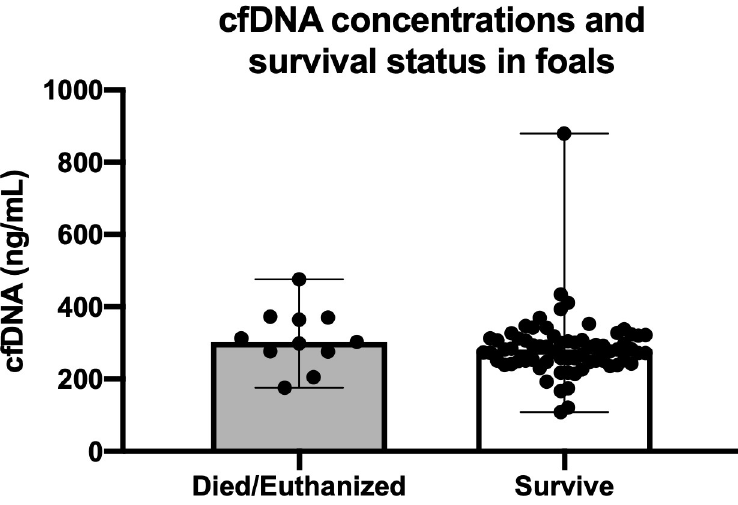
Fig 4. Plasma cell-free DNA (cfDNA) concentrations in 80 hospitalized neonatal foals that survived (n = 69) and died (n = 11). Symbols represent values for individual foals with median and interquartile range error bars (P =